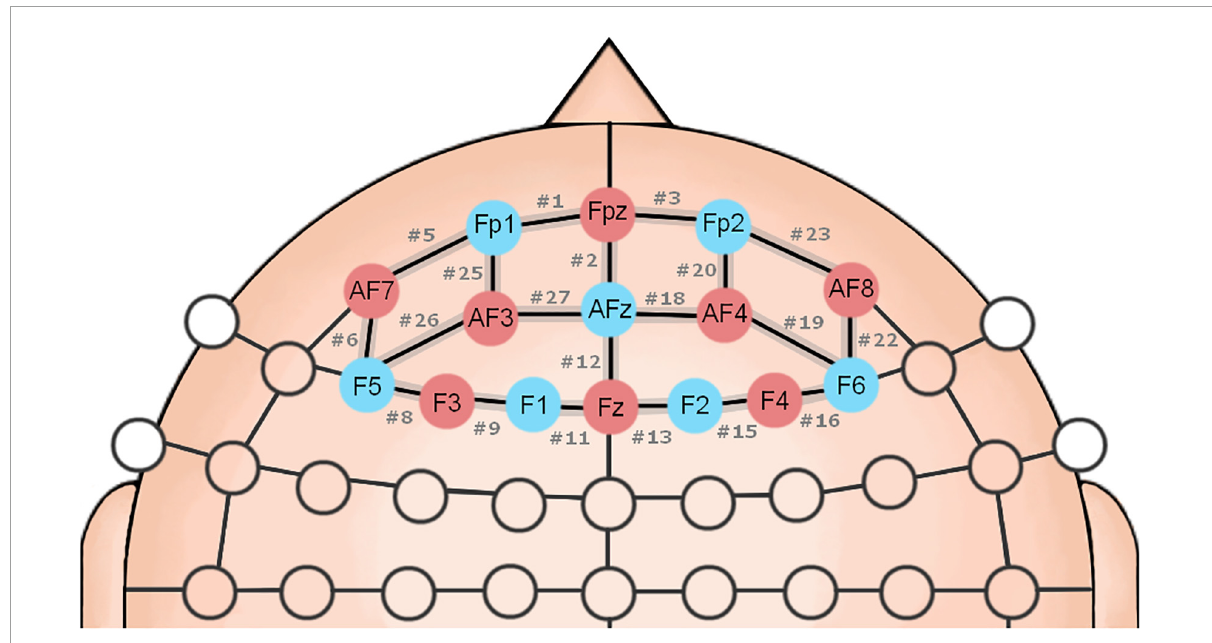
FIGURE1 Schematic representation of the fNIRS optodes positioned over the scalp. The position of the optodes follows the universal configuration of the 10-10 EEG international system. Channels are composed of neighboring optodes represented by the black edges, sources in red (S1–S8) corresponding to F3, AF7, AF3, Fz, Fpz, AF4, AF8, F4, and detectors in blue (D1–D7) matching F5, F1, Fp1, AFz, F2, Fp2, F6. # channel.